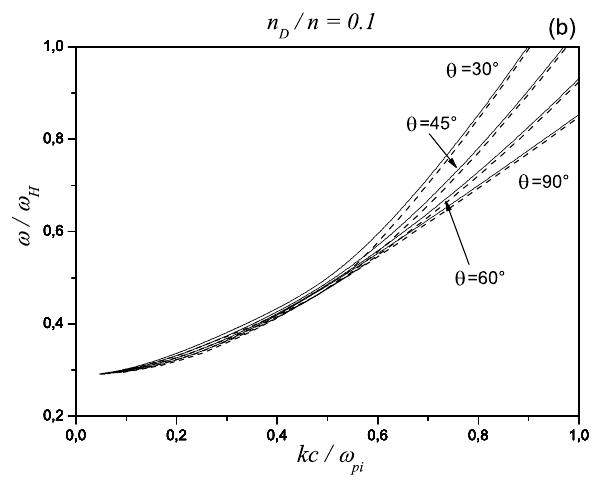
Fig. 1b. Total cold and new dispersion laws (solid and dotted lines, respectively), for the parameters of Fig. 1a but with another fre- quency scale: ω/ω H as a function of kc/ω pi .